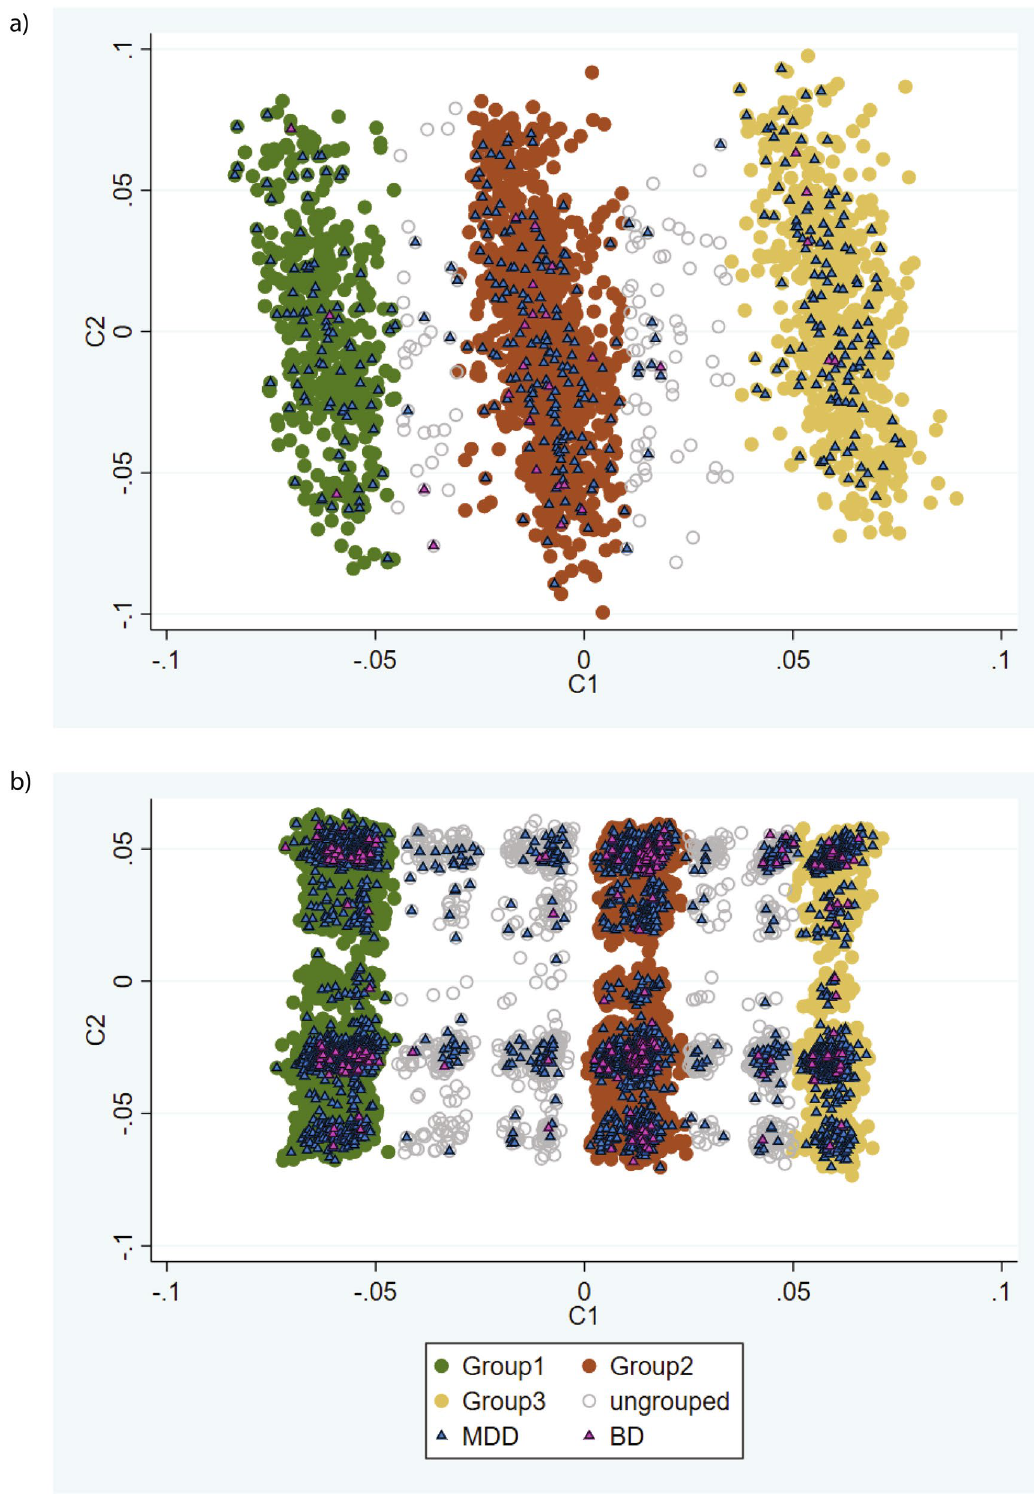
Figure 4. Comparison of the three clusters identified in ( a ) UKB1 and ( b ) UKB2 (lower panel). Each data point is an individual therefore the individuals who are closer together are more genetically